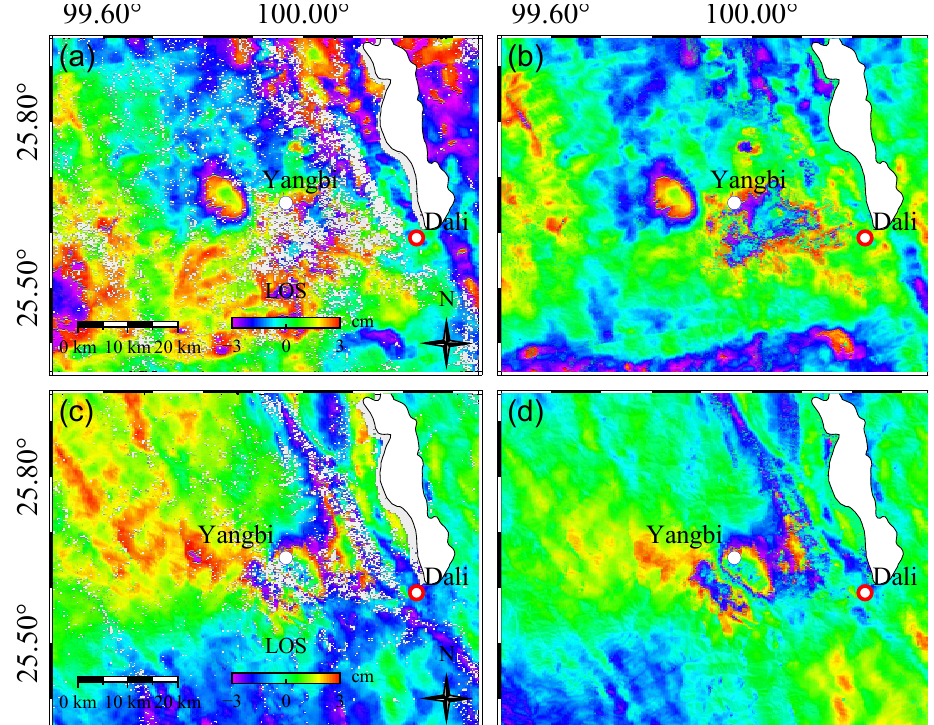
Figure 2. Original and final interferograms of ASC and DSC. One fringe corresponds to a 6 cm surface deformation along the LOS direction. ( a , c ) are the original interferograms, ( b , d ) show the final interferograms with atmospheric and orbital corrections.